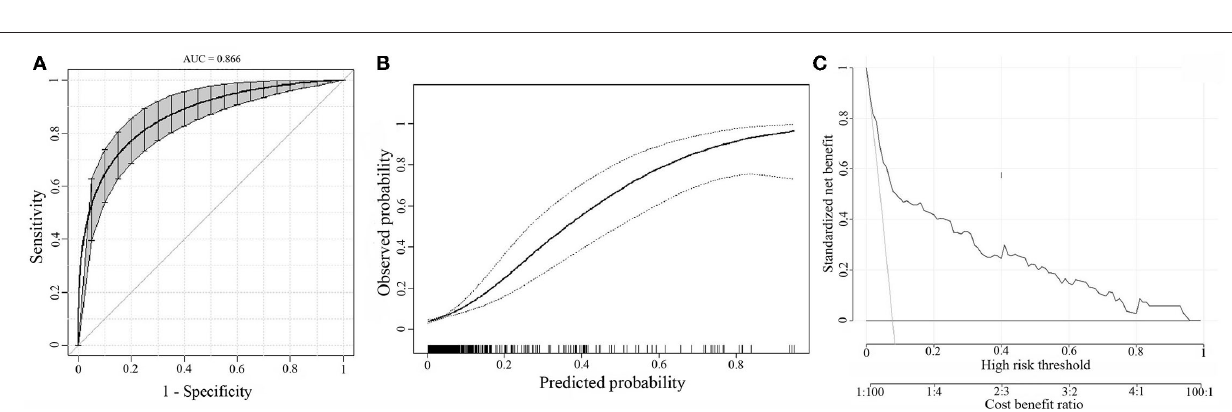
(27). Serum urea nitrogen level is a factor incorporated in other predictive models, such as blood urea nitrogen level for predicting in-hospital mortality (6, 22) and post-discharge clinical outcomes (4). Heart and kidney interactions are complex,